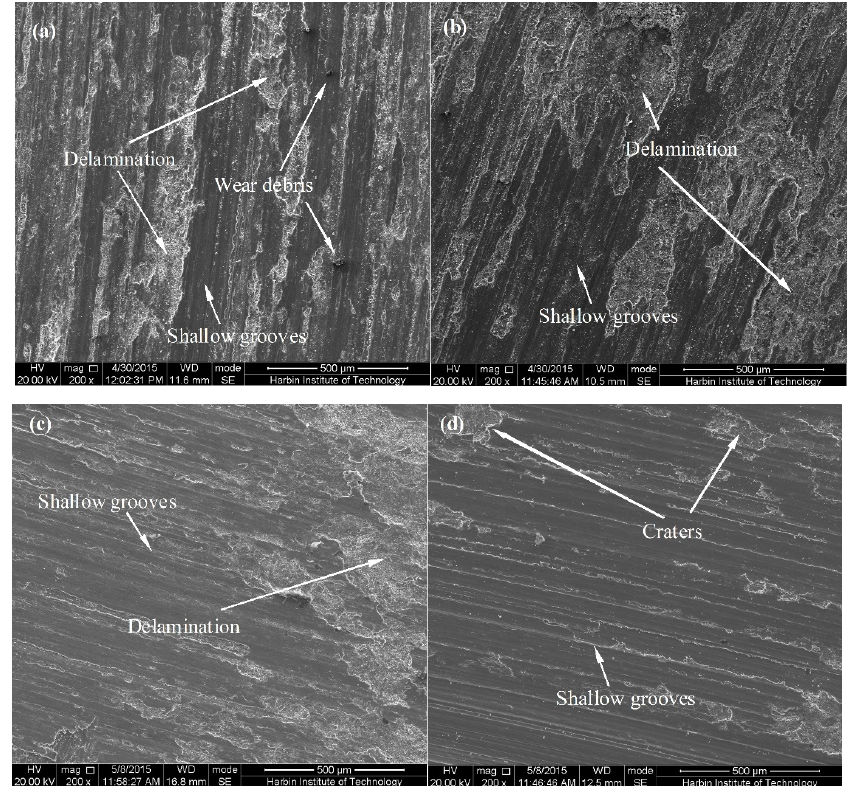
Figure 6. Worn surface morphology of the thixoformed composite parts at different reheating temperatures: ( a ) 580 °C, ( b ) 590 °C, ( c ) 600 °C and ( d ) 610 °C. temperatures: ( a ) 580 ◦ C, ( b ) 590 ◦ C, ( c ) 600 ◦ C and ( d ) 610 ◦